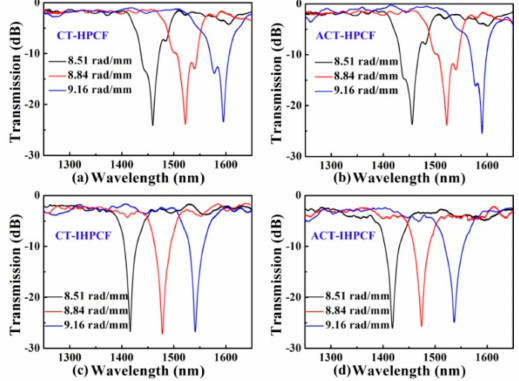
Figure 17. Transmission spectra for ( a ) CT-HLPFG; ( b ) ACT-HLPFG; ( c ) CT-IHLPFG; and ( d )